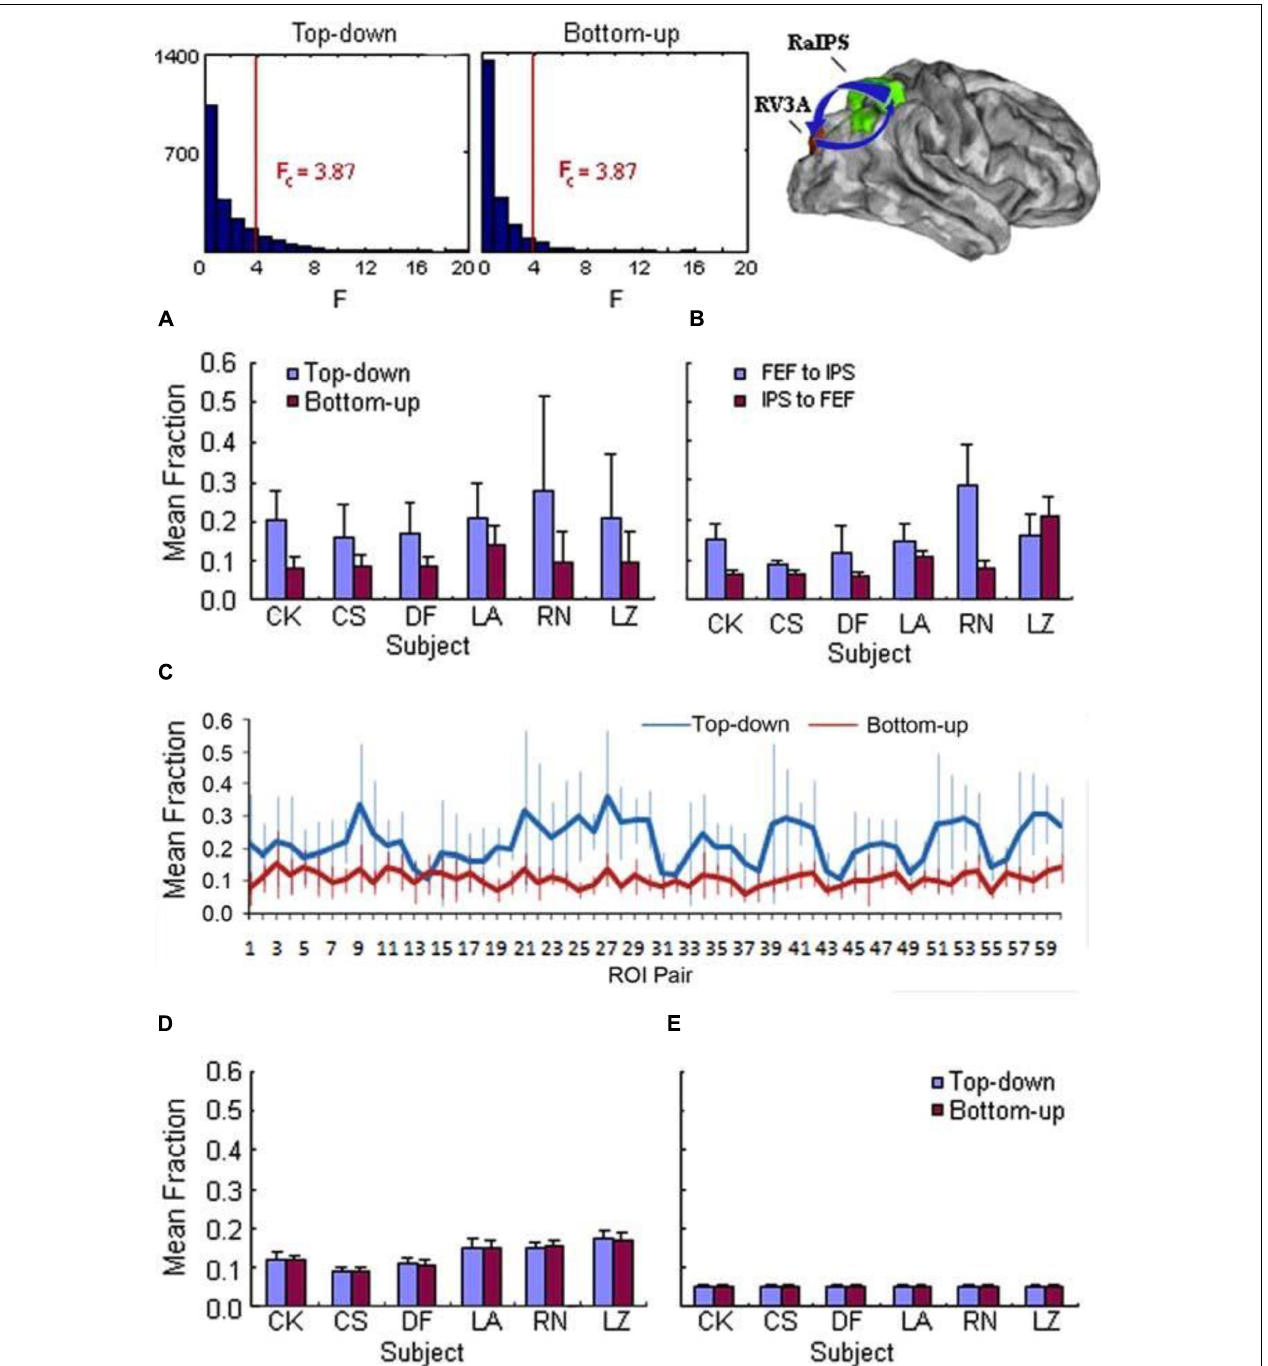
FIGURE 3 | Top row. Top-down (top left) and bottom-up (top middle) Granger causality F -statistic histograms for a representative ROI pair, right aIPS and right V3A, in one subject. The critical value of F is 3.87 for significance ( p < 0.05) in both directions. A larger fraction of the total number of voxel pairs (1064) had significant F statistics in the top-down (16.9%) than in the bottom-up (8.7%) direction. The schematic diagram (top right) showed Granger causality represented as arrows in the two directions between these ROIs on a standard brain image. Arrow thickness corresponds to the significant fraction, representing Granger causality strength. Bottom Top-down Granger causality before correct versus incorrect performance. (A) Grid specifying the significance of correct versus incorrect performance difference in a group analysis of top-down Granger causality: * p < 0.05, ** p < 1.0 × 10 10 , *** p < 1.0 × 10 30 ; white, not significant. Each cell represents Granger causality from the row-labeled ROI to the column-labeled ROI. (B) The fraction of significant top-down Granger causality from right aIPS to left VP was significantly greater before correct (blue) than incorrect (red) performance in five of six subjects [Figure modified from Bressler (2018)].